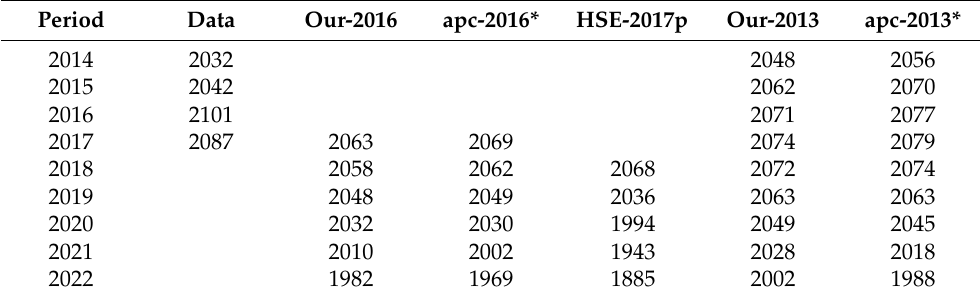
Figure 5. Forecasts of the annual number of deaths using different values of κ . The observed past numbers of deaths are indicated by dots. Table 1. Mesotheolioma mortality forecasts in the UK. Five forecasts of numbers of deaths are compared: “our-201x” corresponds to our proposal using data up to 201x and constant calendar effect; “apc-201x*” to the discrete approach of [19] using data up to 201x and truncating cohorts from 1966 (x = 3, 6); and HSE projections also using provisional data for 2017, “HSE-2017p”. Available data are shown for assessing